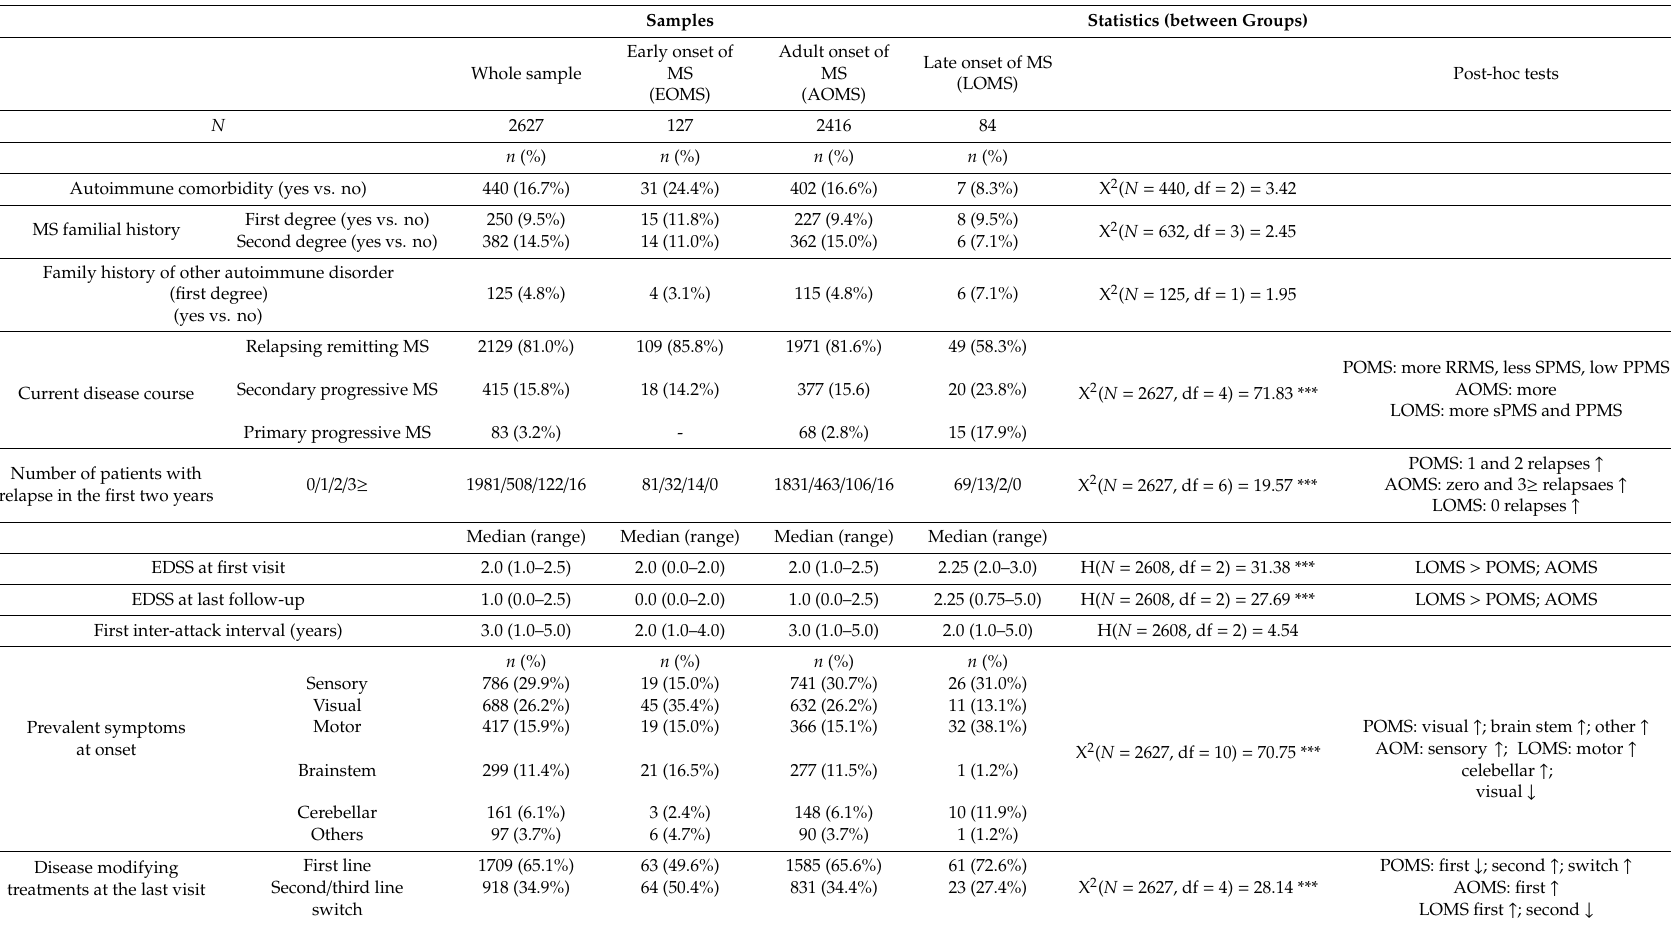
Table 2. Descriptive and inferential statistical indices of clinical characteristics between participants with early onset (EOMS), adult onset (AOMS) and late onset Multiple Sclerosis